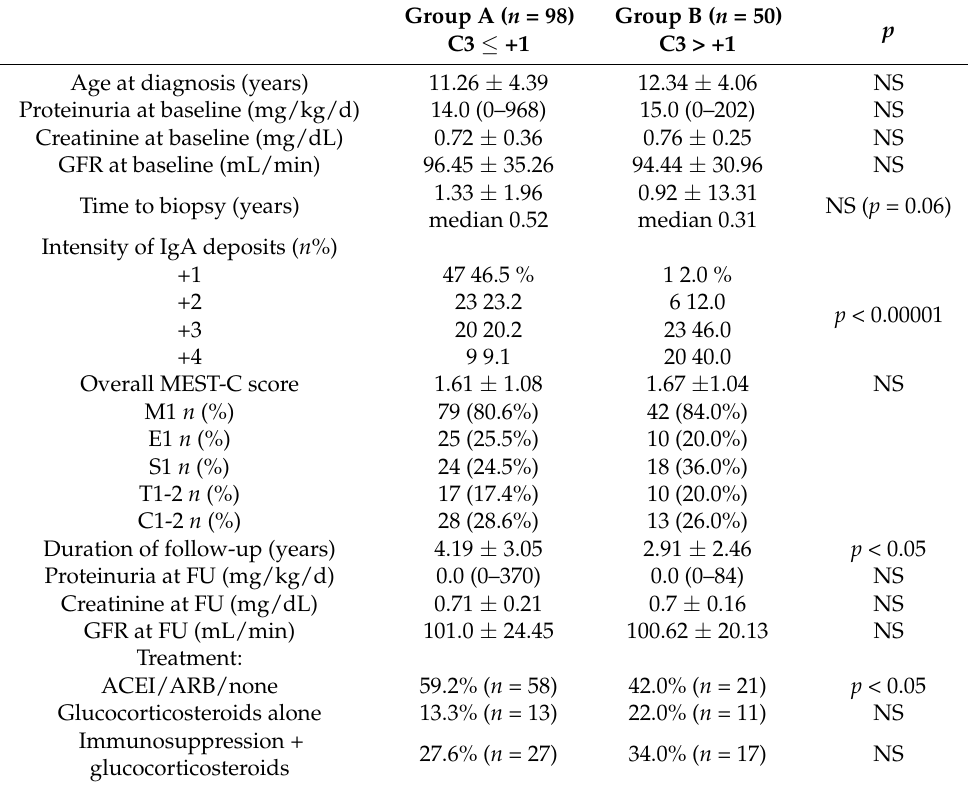
Table 2. Clinical characteristics of the patient groups based on the severity of C3